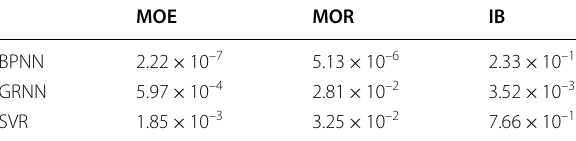
Table 4 Significances ( P -values) of ANOVA test results for prediction bias